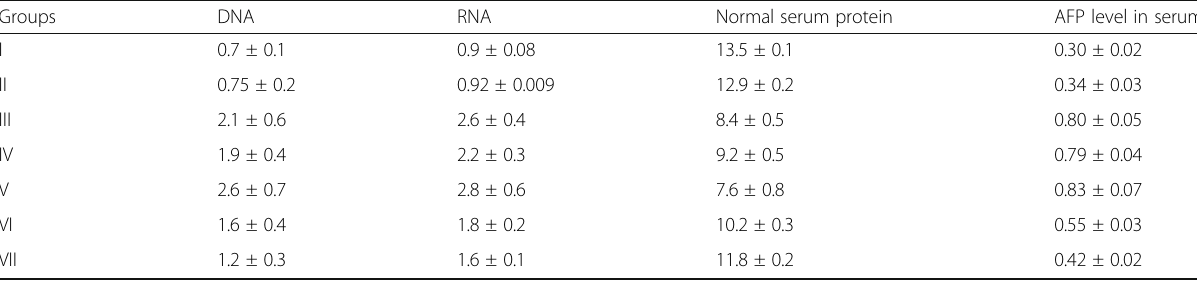
a Values represented means ± SD * Significantly different from the control groups ( p <